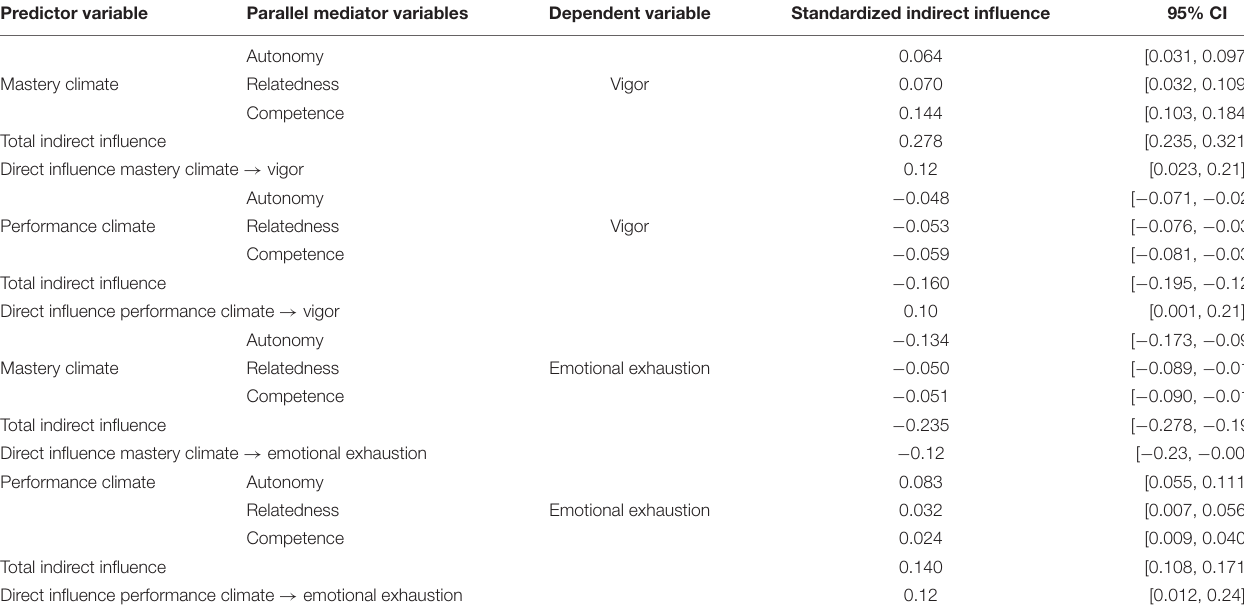
TABLE 4 | Bootstrap analyses of the magnitude and significance of direct, indirect, and total